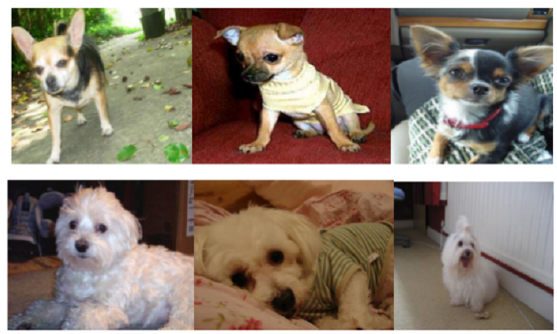
Figure 7. Sample images from the Stanford Dogs dataset.